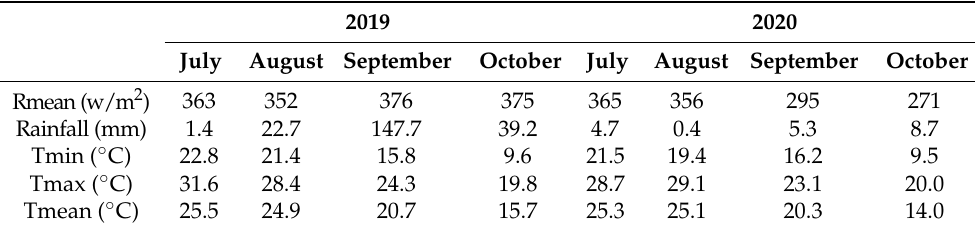
Table 1. Climatic conditions during two seasons (2019 and